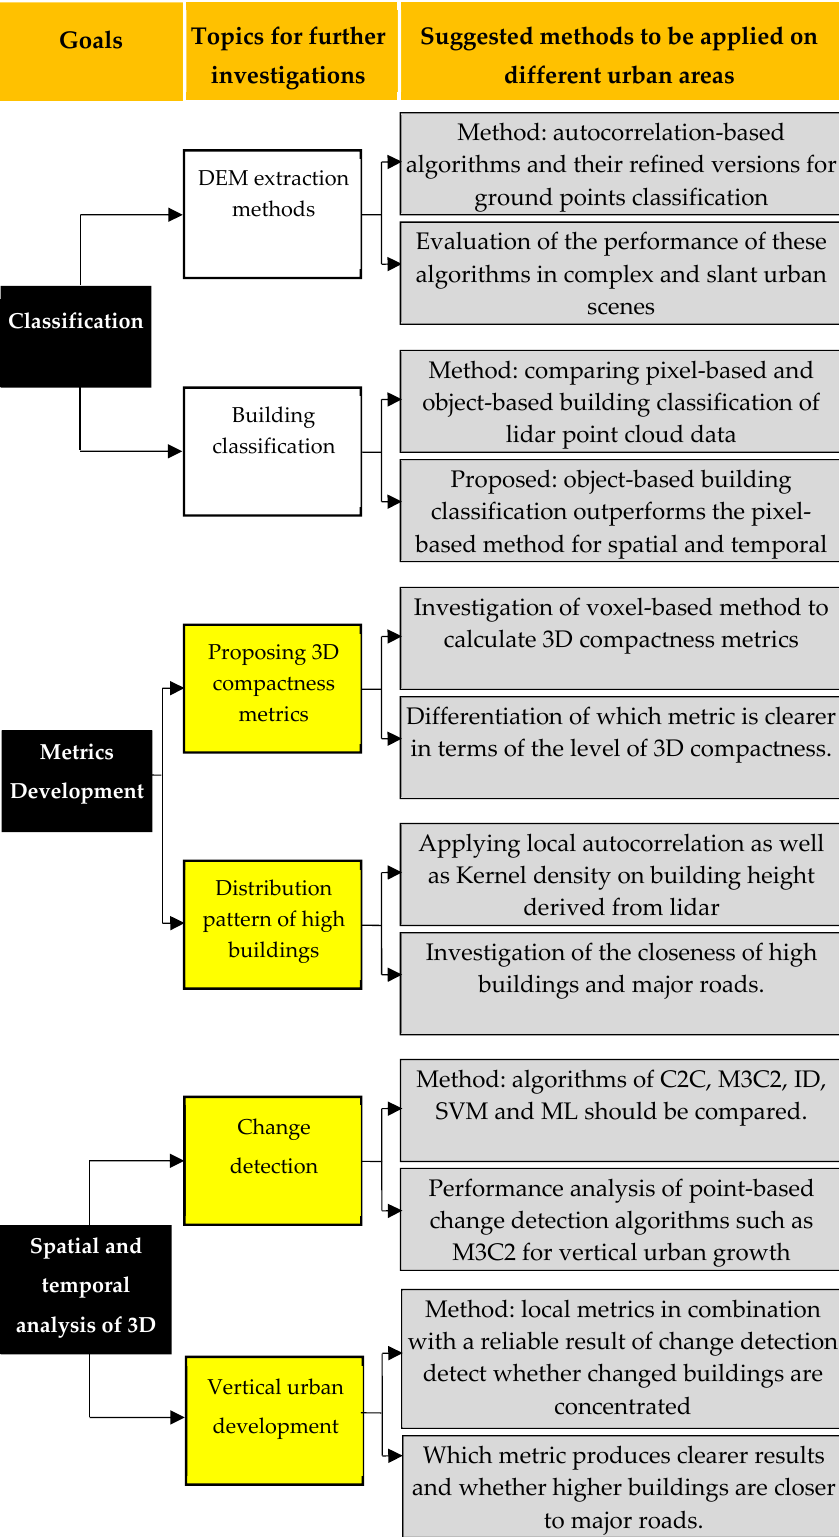
Figure 14. Summarised research methods suggested for further investigations in different urban areas in different countries. Note: SVM, ML, ID, C2C, M3C2 refer to support vector machine, maximum likelihood, image differencing, cloud to cloud, multiscale model to model cloud